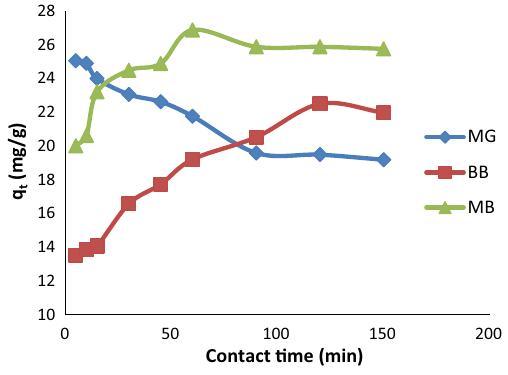
Fig. 2 Effect of adsorbent dosage on adsorption of Zn(II) Fig. 3 Effect of contact time on adsorption of